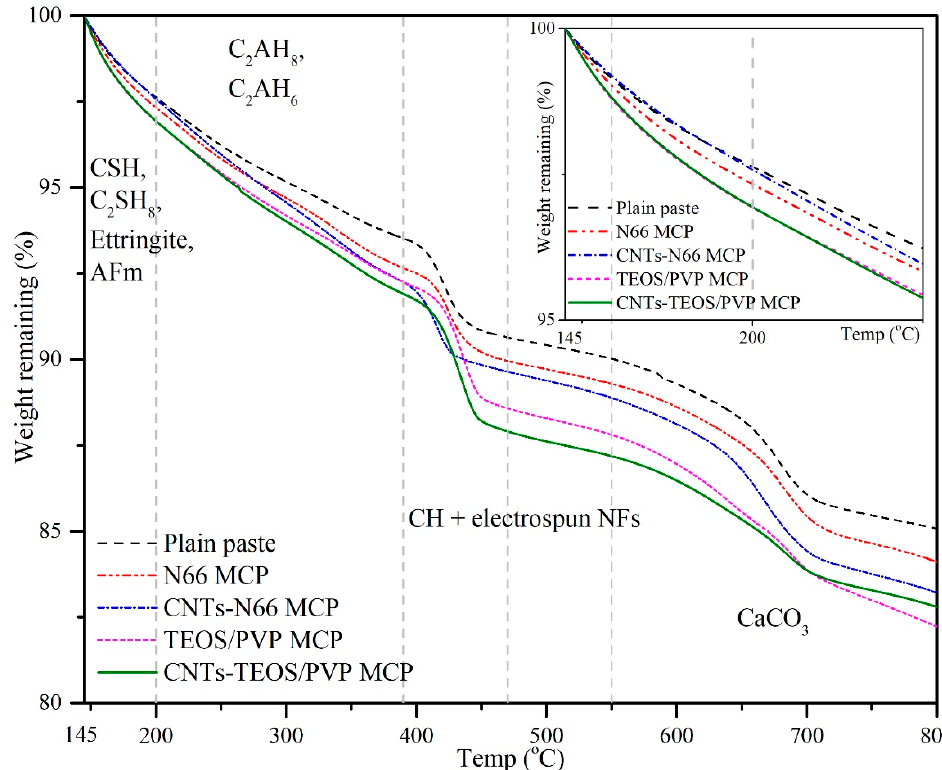
Figure 8. TGA curves of the hydrated cement pastes.